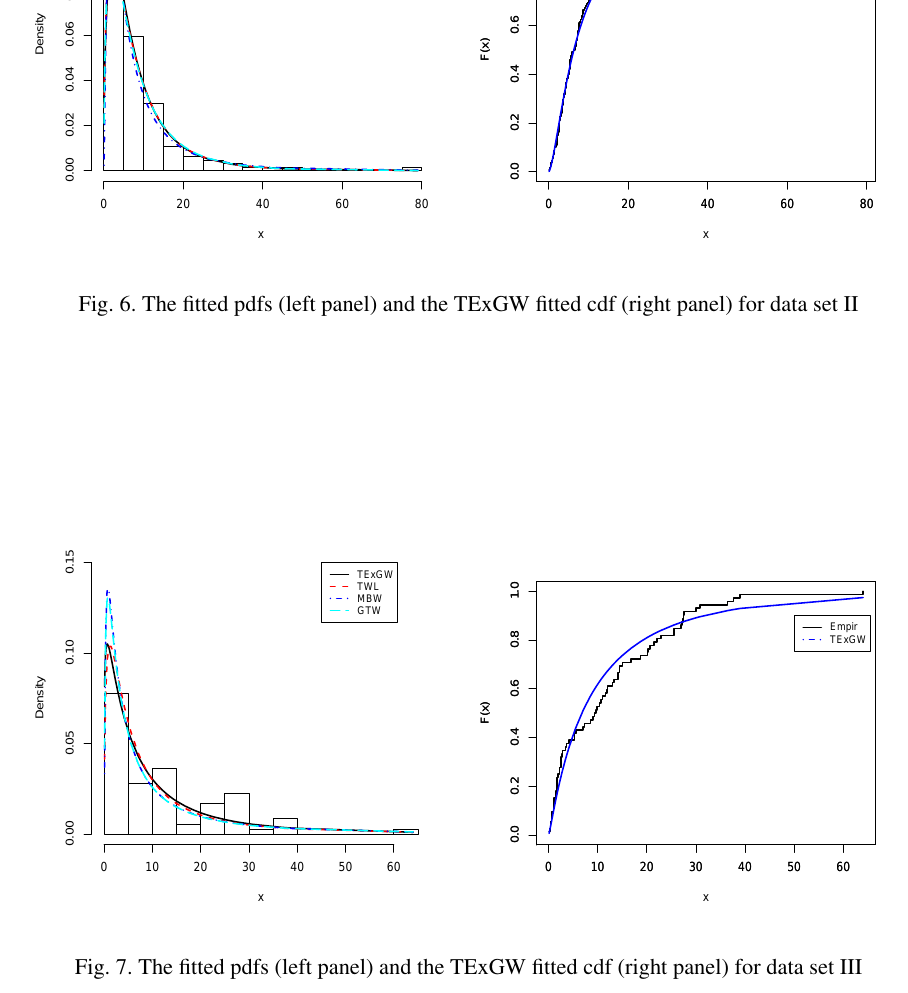
Fig. 7. The fitted pdfs (left panel) and the TExGW fitted cdf (right panel) for data set